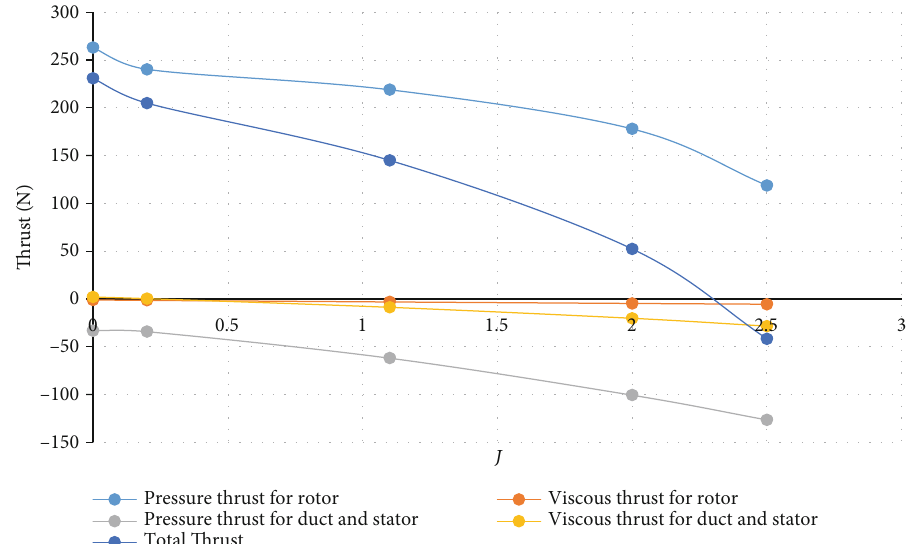
Figure 11: Thrust force calculated for the linear jet system without a stator.